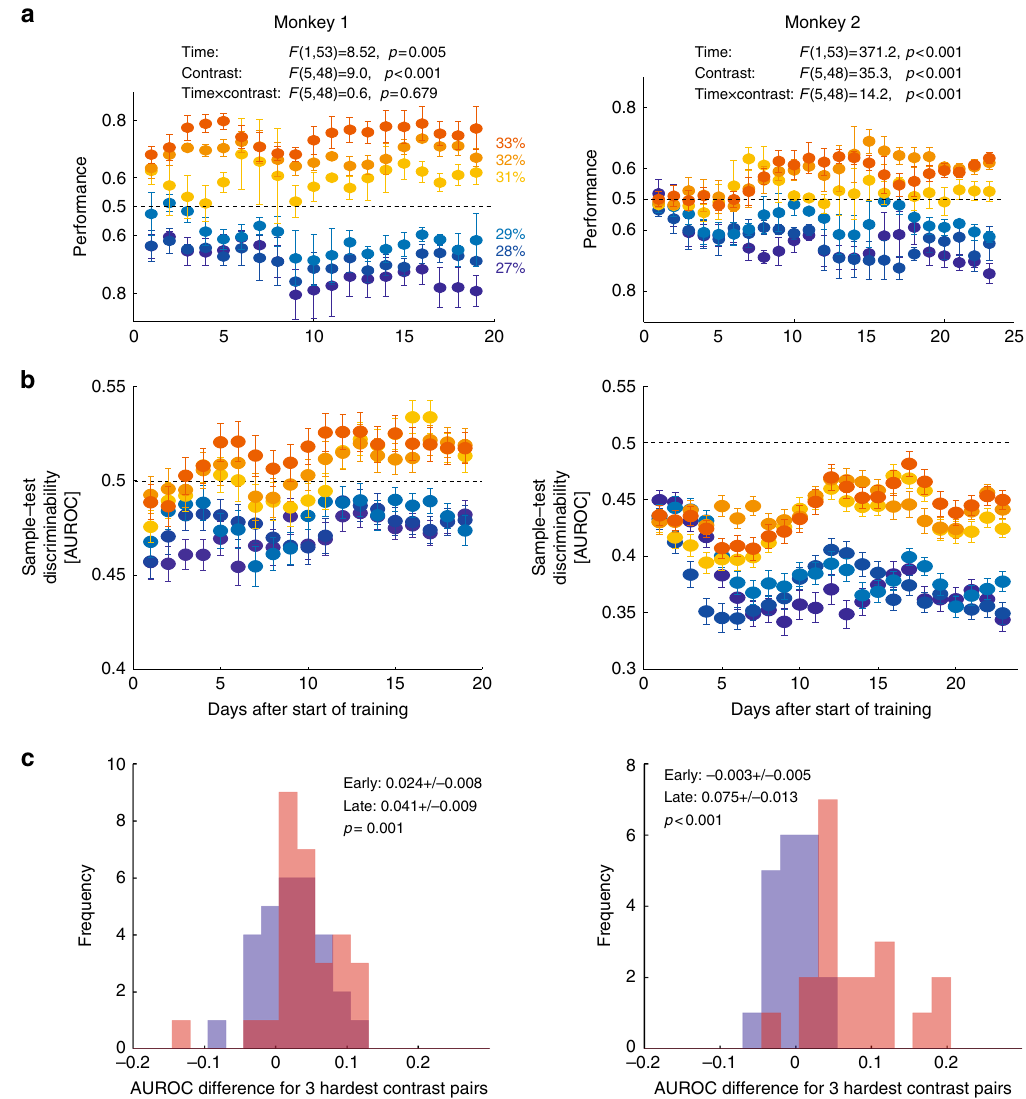
Fig. 3 Changes in behavioural performance and neuronal discriminability with learning. a Behavioural performance for the six most dif fi cult contrast discriminations. Performance for test contrasts lower than sample contrast (blueish colours) is plotted from 0.5 to 1 downwards. Performance for test contrasts higher than sample contrast (reddish colours) from 0.5 to 1 is plotted upwards. Test contrast colour assignment is given by coloured number insets. b Neuronal discriminability (AUROC) for sample – test contrast in the two monkeys with learning. Sample – test contrast colour assignment is given by coloured number insets in a . c Distribution of discriminability difference for the 3 most dif fi cult sample test – contrast comparison pairs (e.g. 31% AUROC – 29% AUROC, 32% AUROC – 28% AUROC, 33% AUROC – 27% AUROC) for the fi rst 5 days of learning (blue) and for the last 5 days of learning (red) across all channels recorded. Darker red shades show overlap of the two distributions. Insets display the mean and S.E.M. of the two distributions. p Values indicate whether distributions differed signi fi cantly. Performance and discriminability for each data point is the average over 3 consecutive days, i.e. error bars in a , b denote S.E.M. of a 3-day performance (AUROC) average (thus the number of data points are the total number of recording days minus